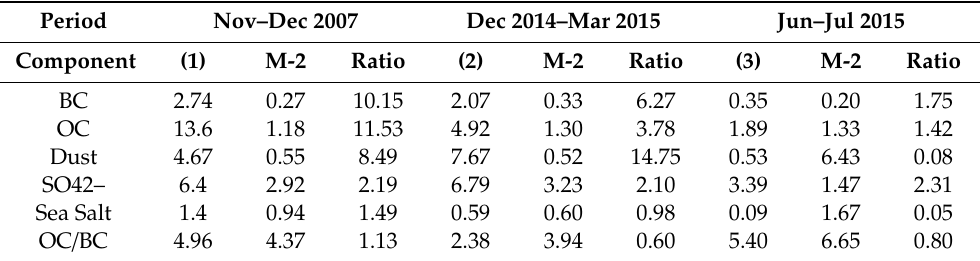
Table 2. Comparison of PM 2.5 concentrations ( µ g m − 3 ) in components reported by MERRA-2 (M-2) with those reported in other MMA